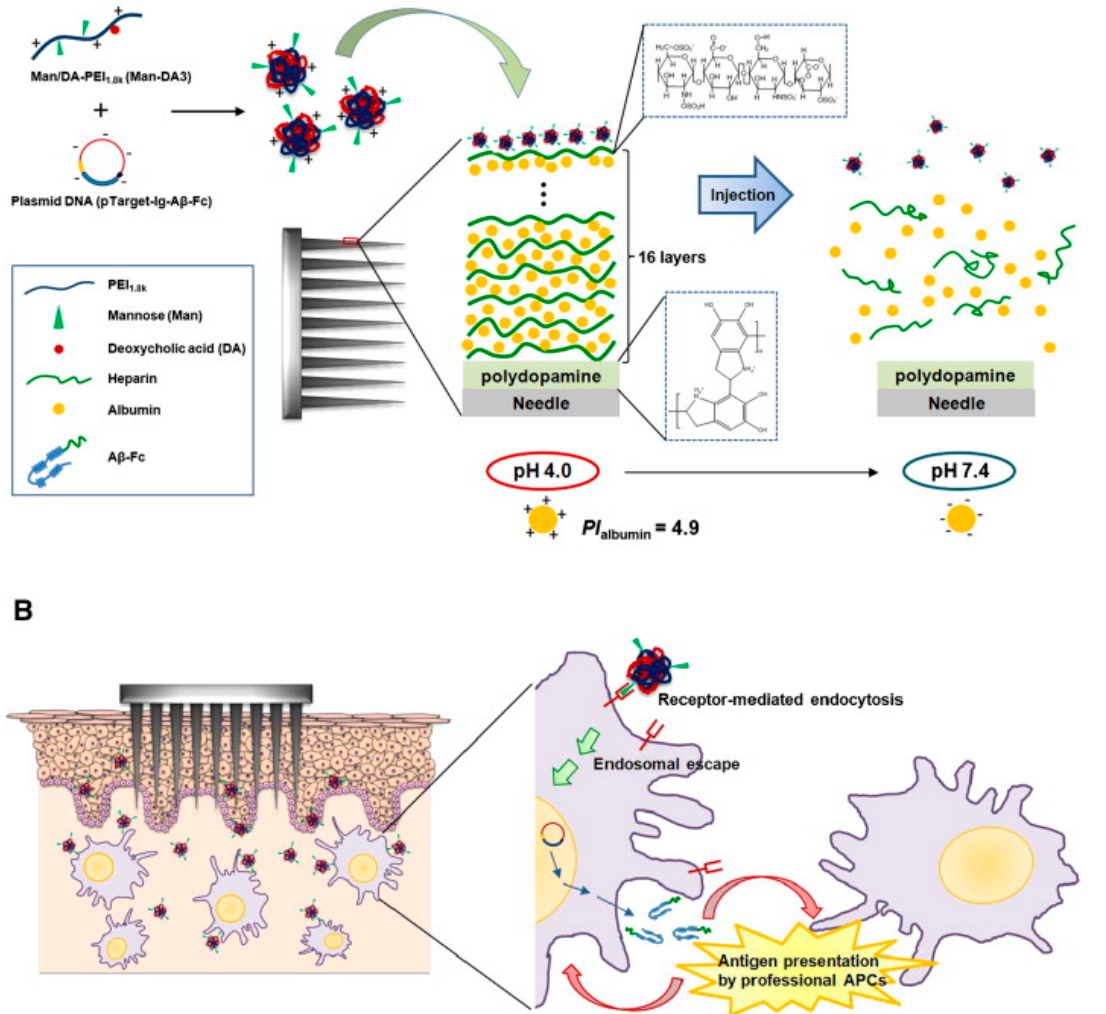
Figure 4. ( A ) Schematic illustration of the release of functional polyplexes from microneedle arrays (MNs) coated with pH-responsive polyelectrolyte multilayer assembly upon application to the skin. ( B ) Targeted delivery of polyplexes with surface mannose moieties to intradermal resident antigen presenting cells (APCs) after release from the MNs. Reproduced from Kim et al. (2014) [32] with permission (Copyright © 2014 Elsevier Inc. All rights reserved.).